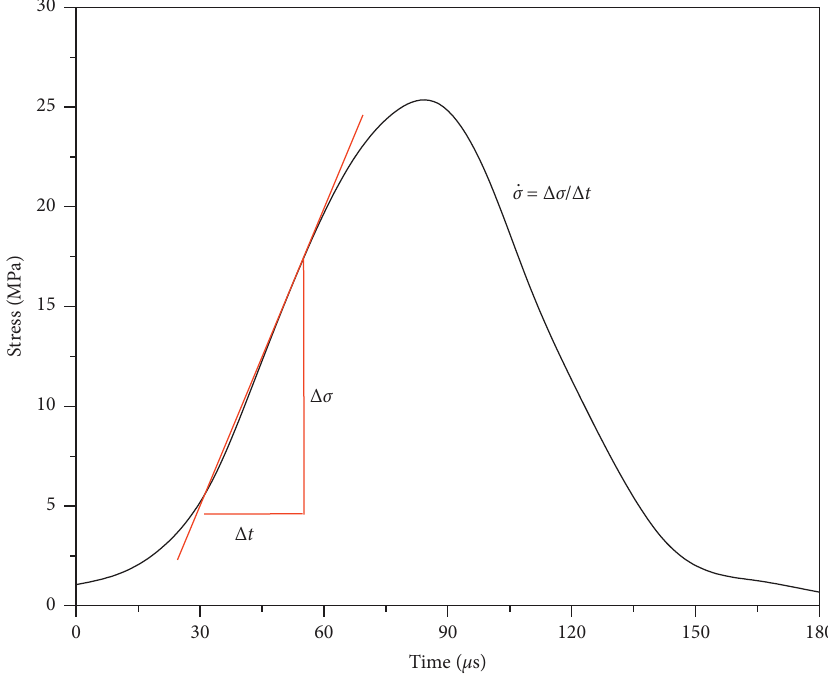
Figure 3: History of dynamic tensile strength in the center of the red sandstone sample.